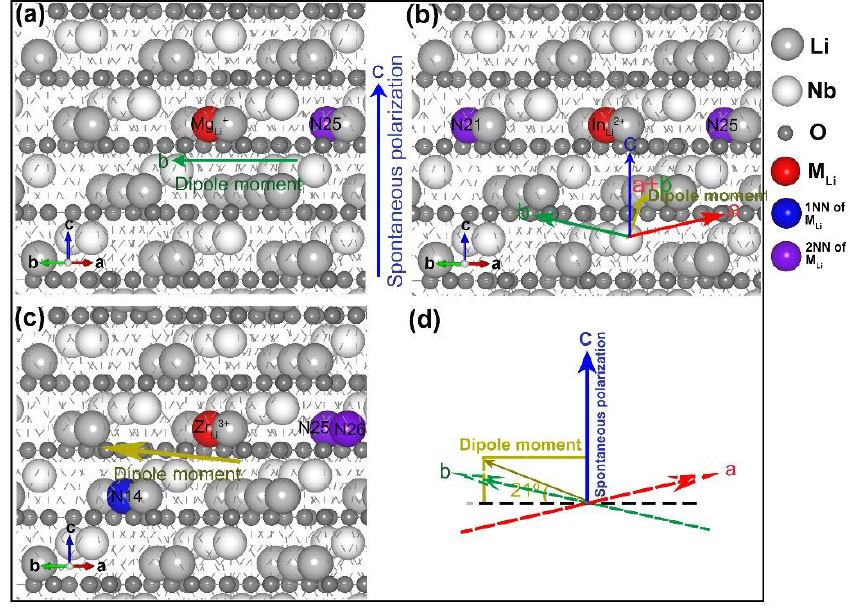
Figure 4. The most stable model of LN:Mg ( a ), LN:Sc, ( b ) and LN:Zr ( c ). The dopants ions Mg 2+ , Sc 3+ , and Zr 4+ are represented by red balls in the figure, respectively. Blue and purple balls are lithium vacancies in 1NN and 2NN site of dopant ions. In addition, the blue arrow shows the direction of spontaneous polarization of crystal, while green arrows and yellow arrows indicate the direction of the dipole moment in ( a – c ). ( d ) is the amplification structure of the dipole moment. The red, green, and blue arrows represent the direction of the a , b and c axis in the crystal, and the yellow arrow shows the direction of the dipole moment.